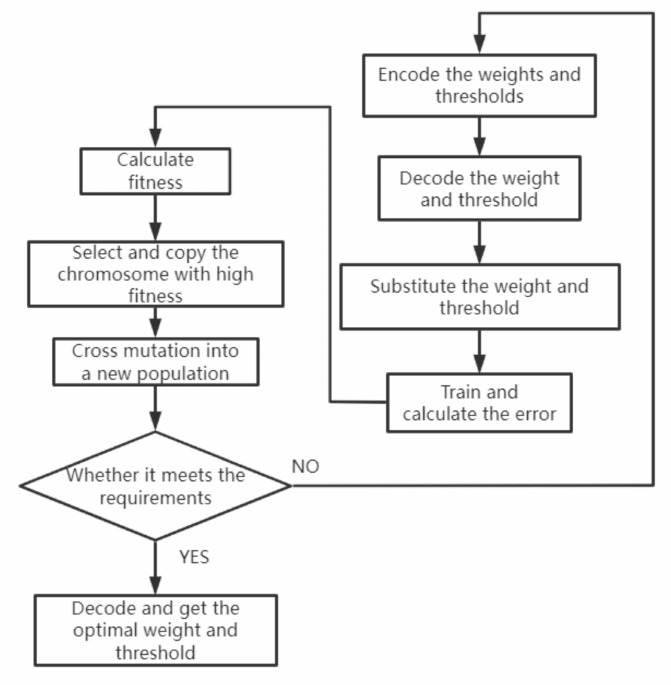
Figure 21. Steps of genetic